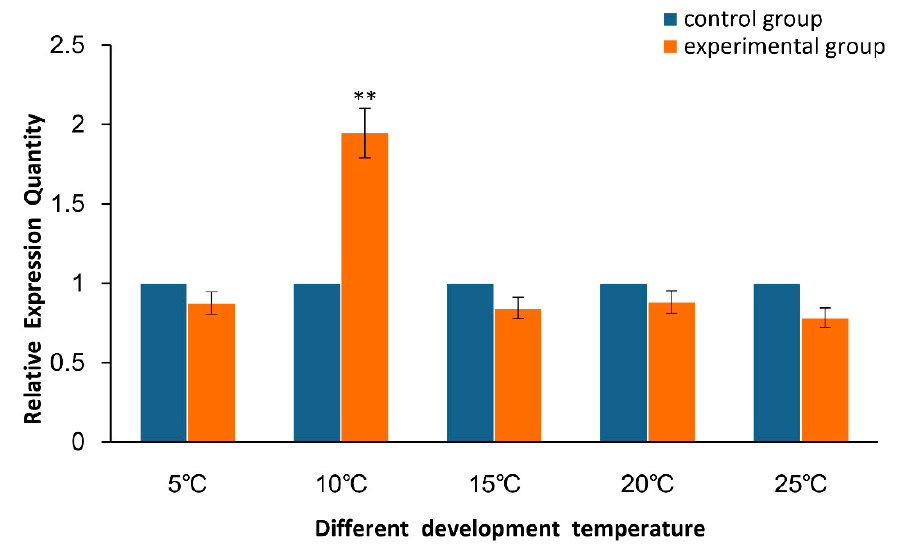
Figure 2. Quantitative real-time qPCR analysis of the expression level of As– RAD9 in different challenge temperatures. The expression level of As– RAD9 mRNA at 30 °C was set as a control group, and the expression level of As– RAD9 mRNA at five different temperatures was measured. Data are mean ± SD of three replicate experiments, and ** indicates a very significant difference compared to the control ( P < 0.01).